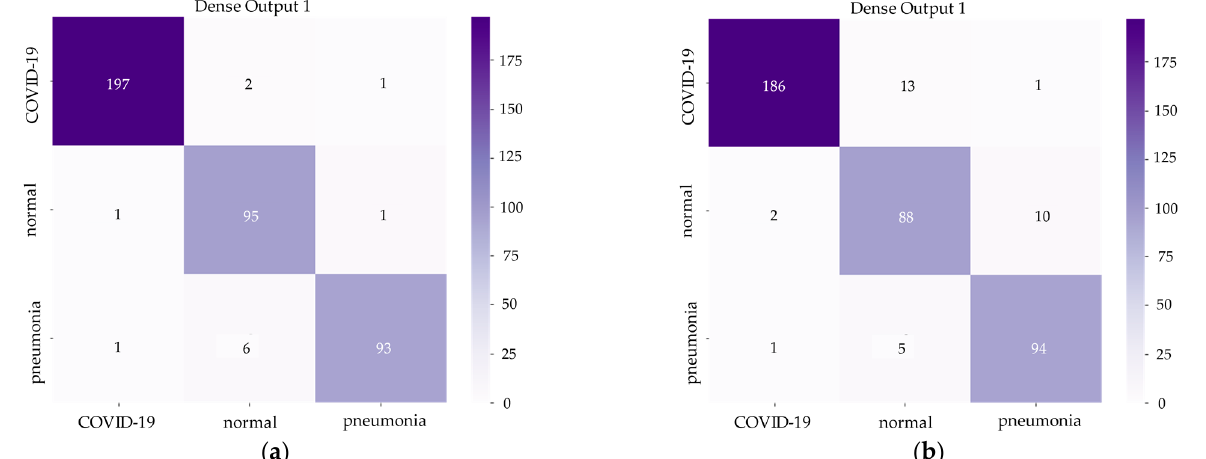
Figure 6. Confusion matrix of ( a ) DenseNet and ( b ) Hybrid EfficientNet-DOLG on the COVID-19 classification task. Darker colors illustrate larger number of the correct predicted labels.